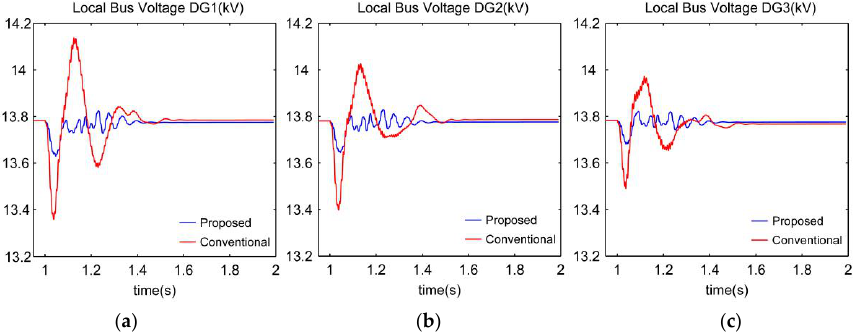
Figure 17. Voltage response of DG’s in load impact condition using proposed supplementary control compare with conventional droop controller ( a ) DG1; ( b ) DG2; and ( c )